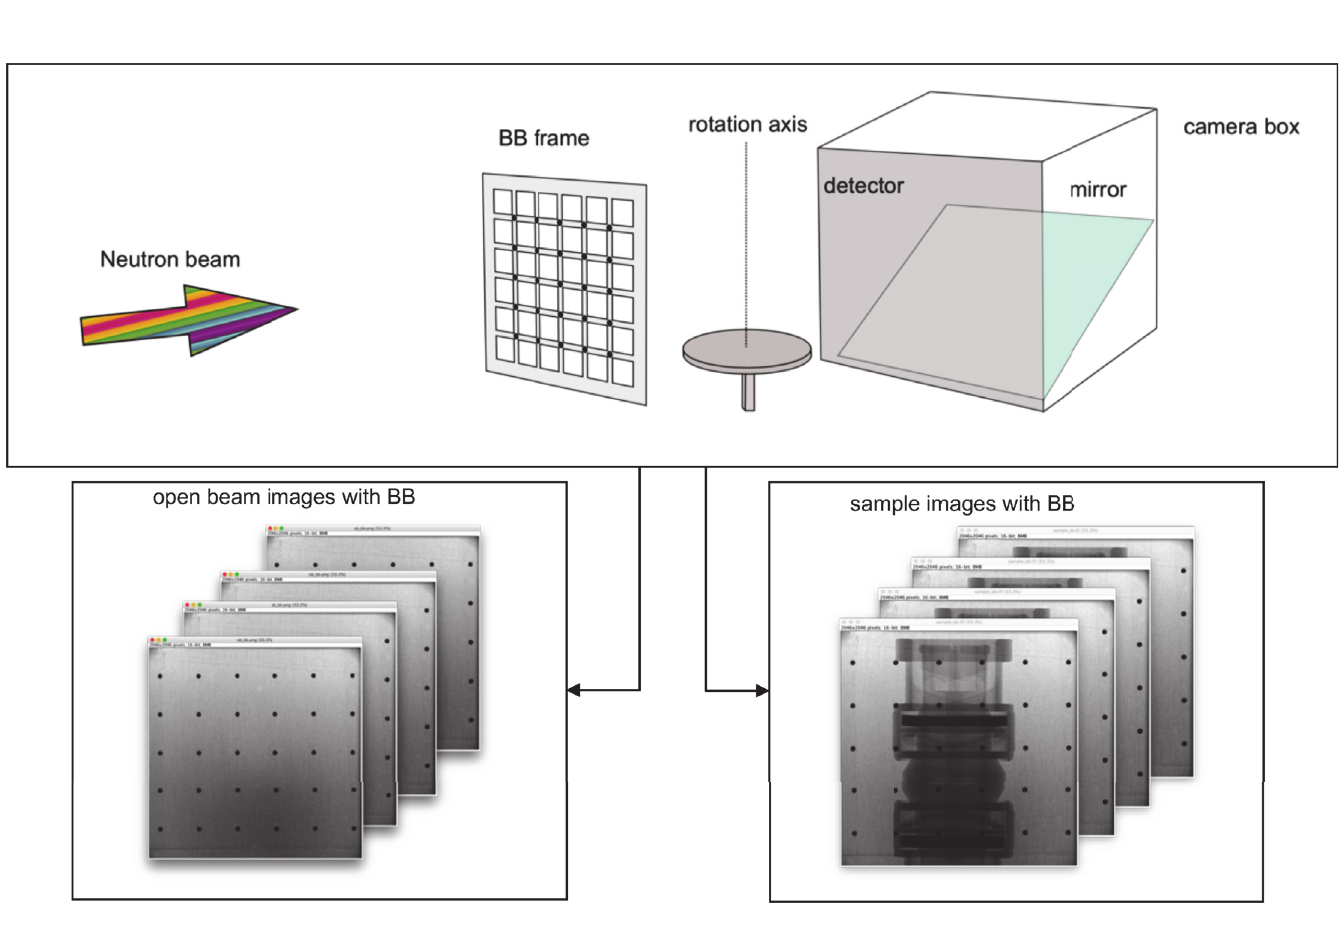
Fig 1. Schematic of image acquisition with interposed BB frame. Two set of images are acquired without the sample (left) and with the sample in the beam (right).